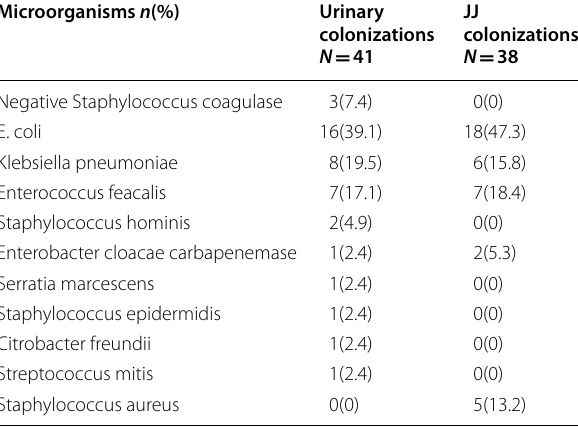
Table 4 The different germs found in urinary culture and the JJ stent